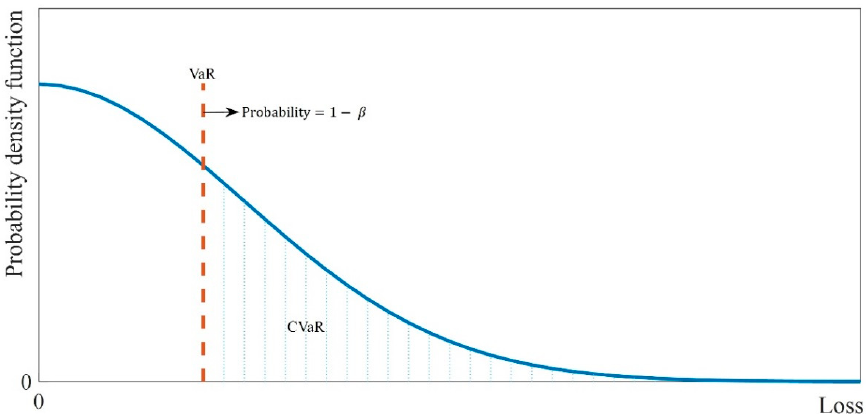
Figure A1. The graphical representation of the CVaR method.